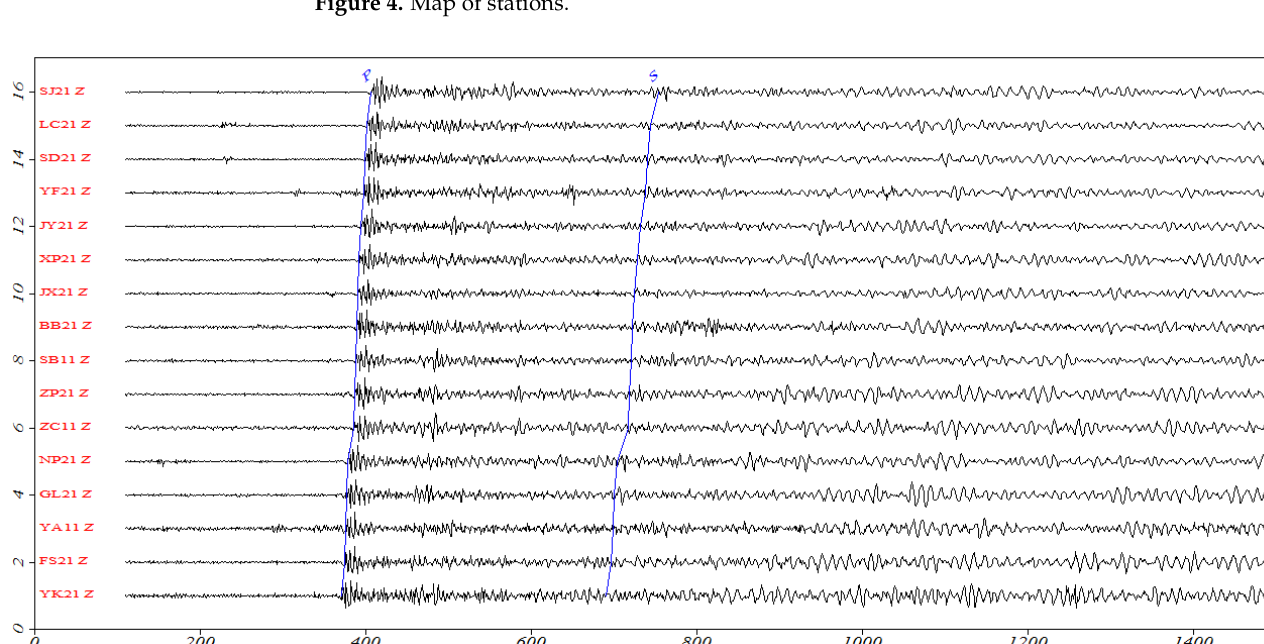
Figure 4. Map of stations.